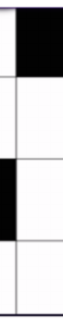
Figure 1. Perfect Piano game.